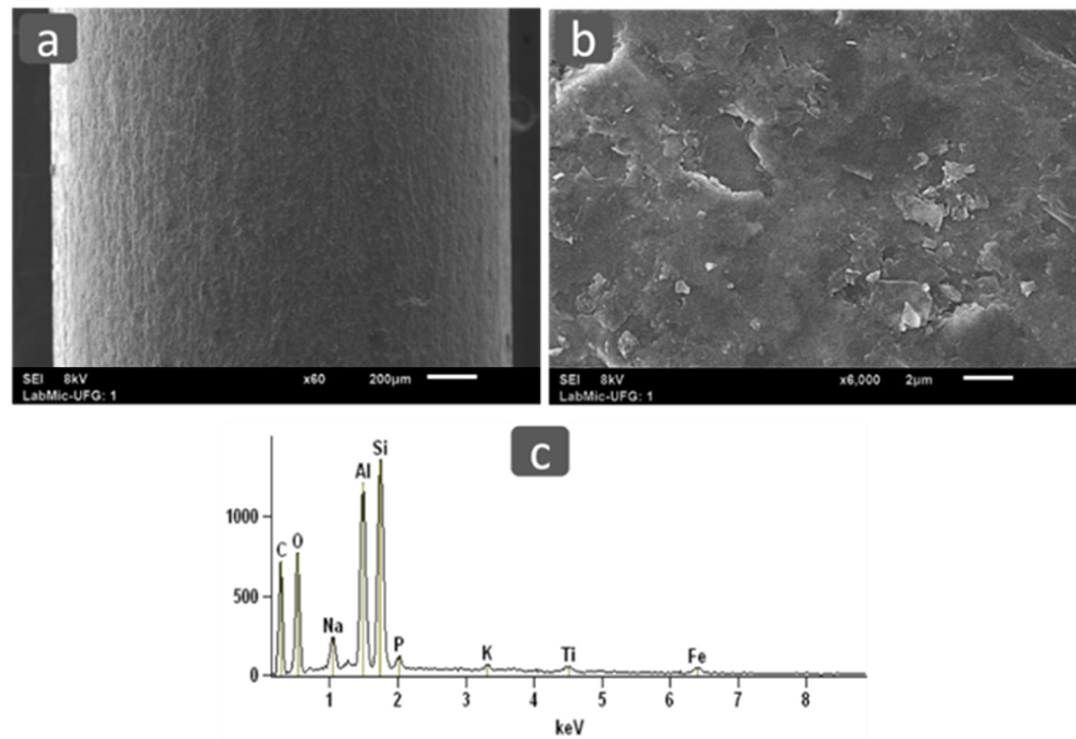
Figure 3. SEM images of pencil graphite surface: ( a , b ) before the deposition of BVO particles; ( c ) EDS spectrum indicating the composition of material after deposition.